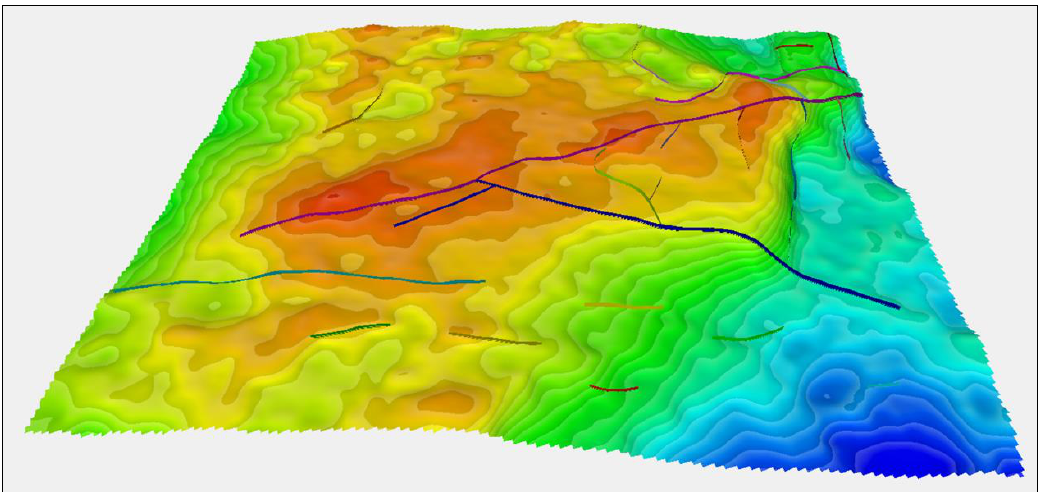
Figure 5. Full-field view of the structural map of the gas reservoir, subject of this study.